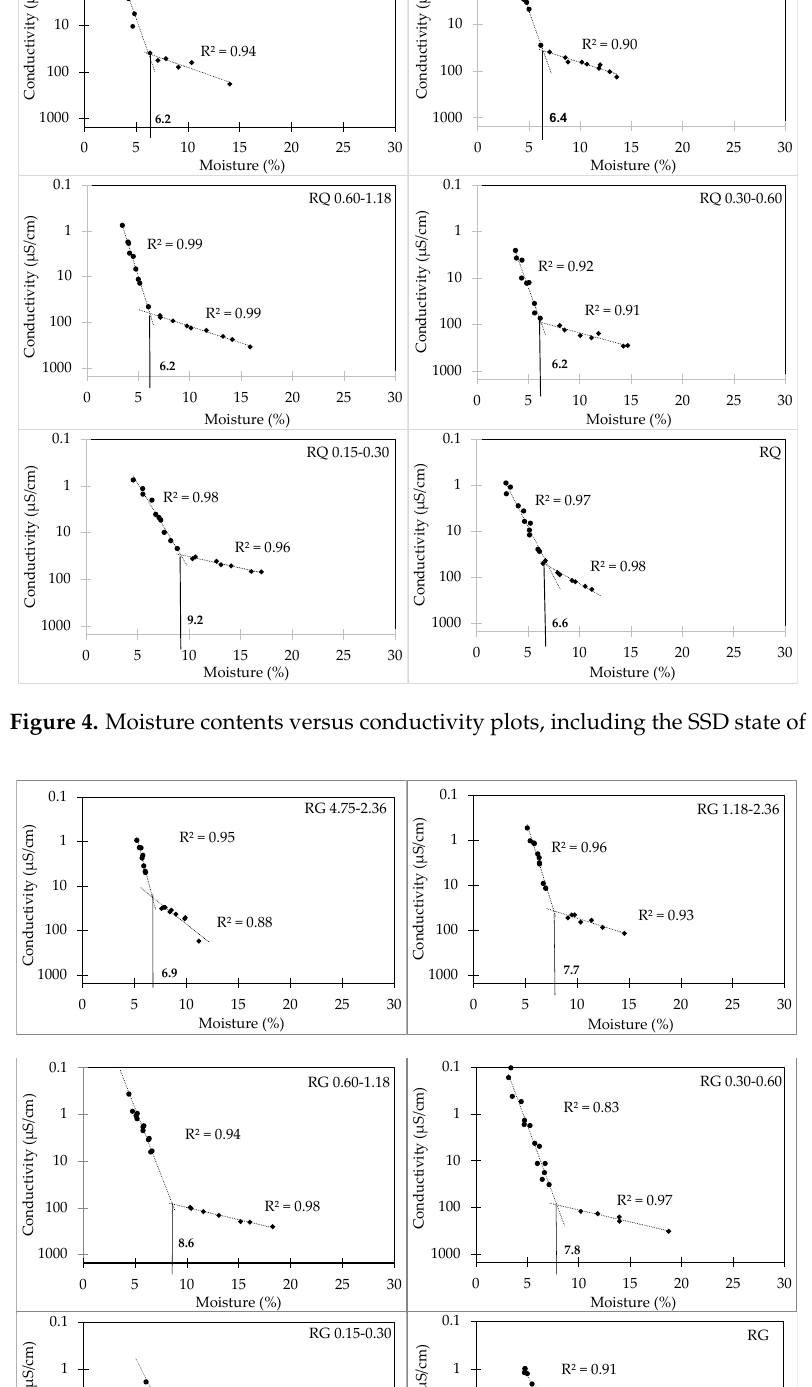
Figure 5. Moisture contents versus conductivity plots, including the SSD state of RG samples.